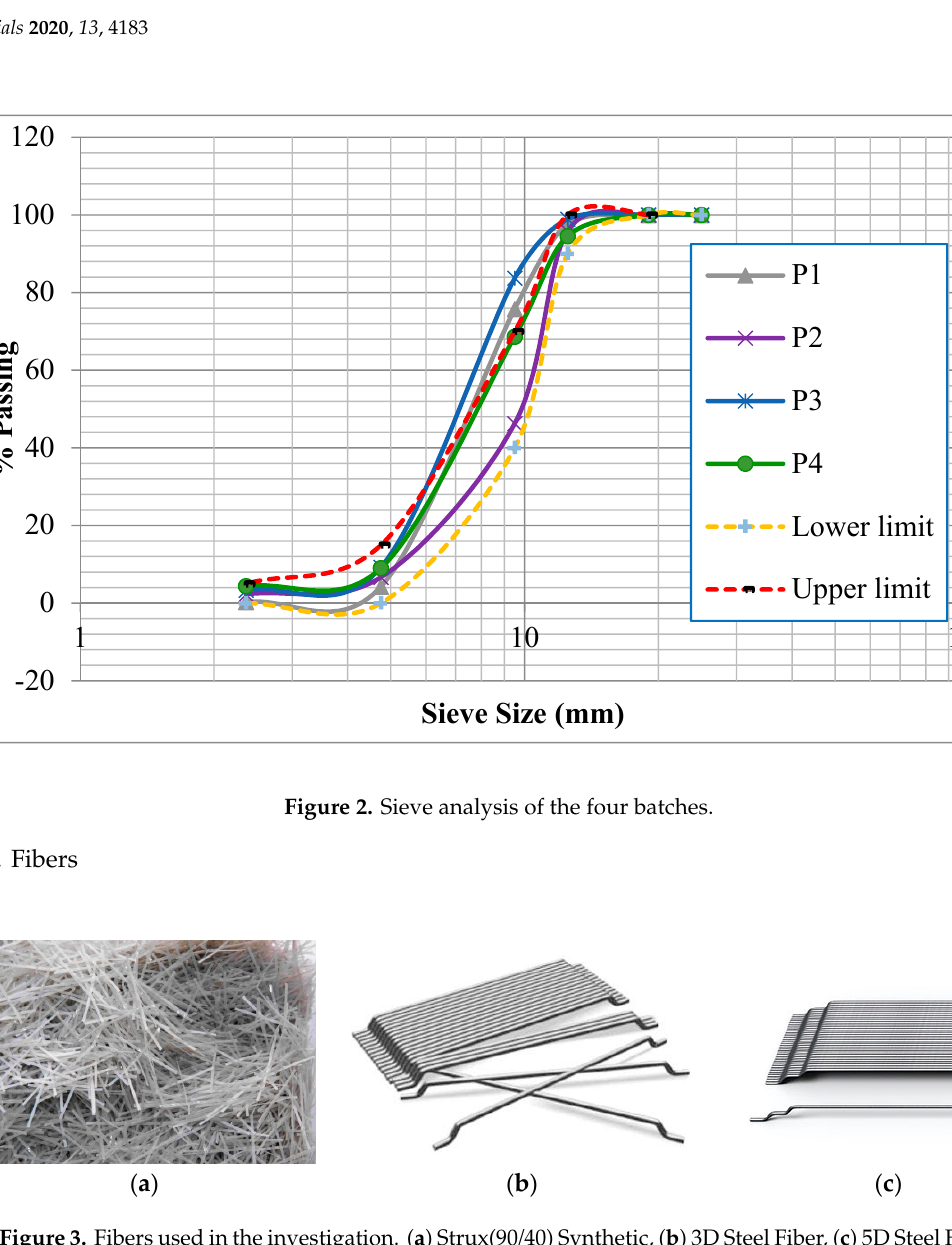
Figure 3. Fibers used in the investigation. (a) Strux(90/40) Synthetic, (b) 3D Steel Fiber, (c) 5D Steel Table 4. Summary of fibers